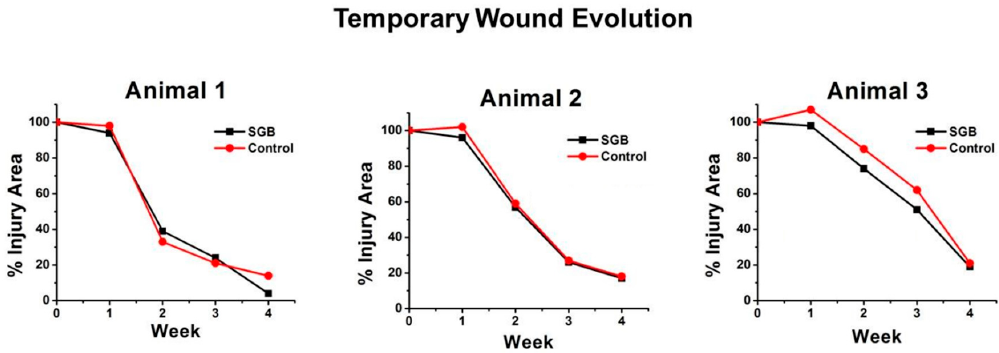
Figure 3. Evolution of the size of wounds (% with respect to initial area) during 4 weeks.